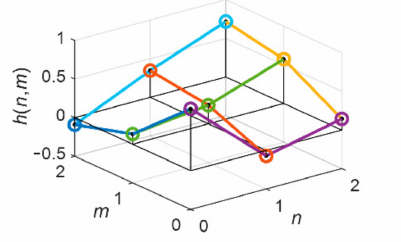
Figure 4. Two-dimensional impulse response h ( n , m ) of the sliding window filter, N =